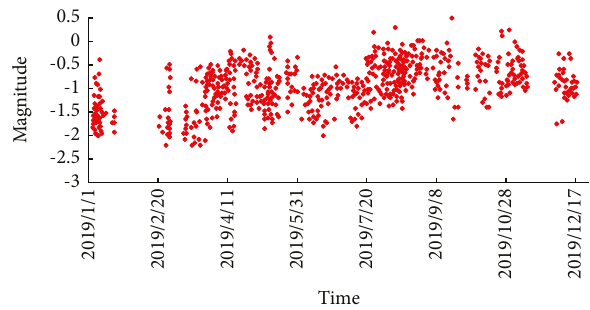
Figure 11: Relationship between magnitude and time of micro- seismic events in the tailrace